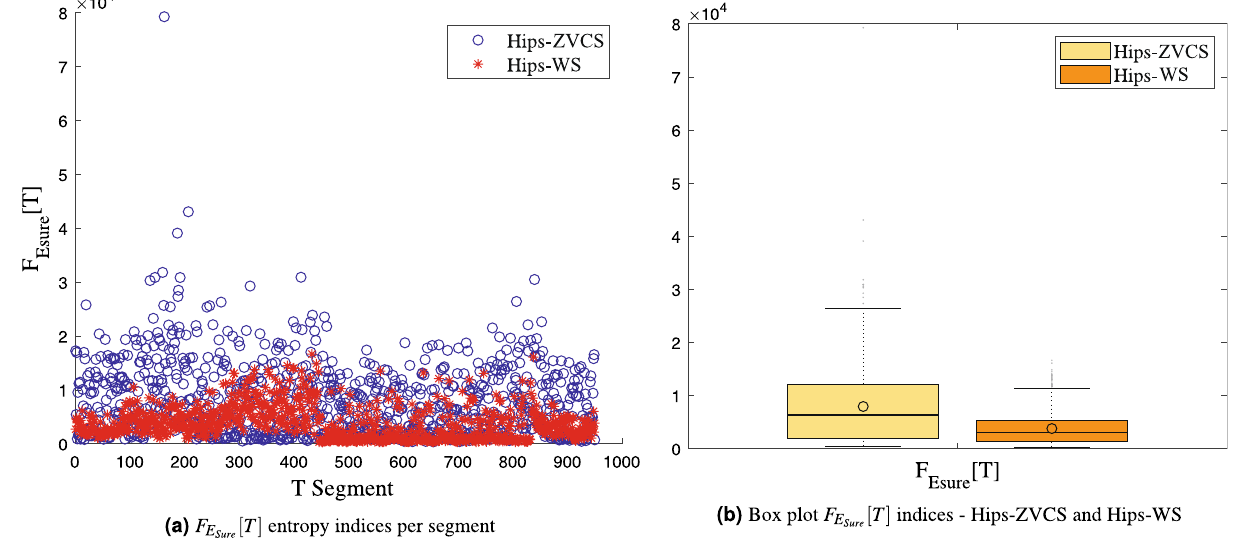
[ T ] entropy measurement indices. Sure